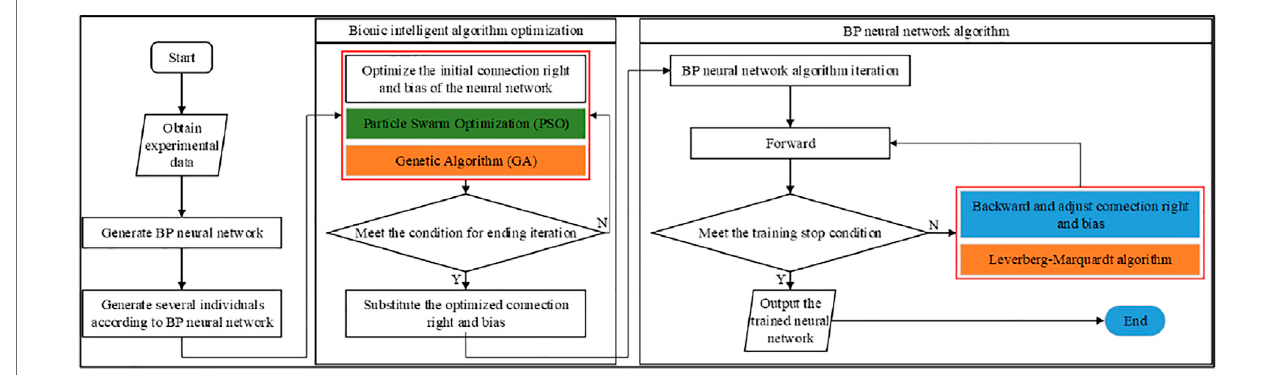
FIGURE 3 | Flow chart of BP neural network optimization